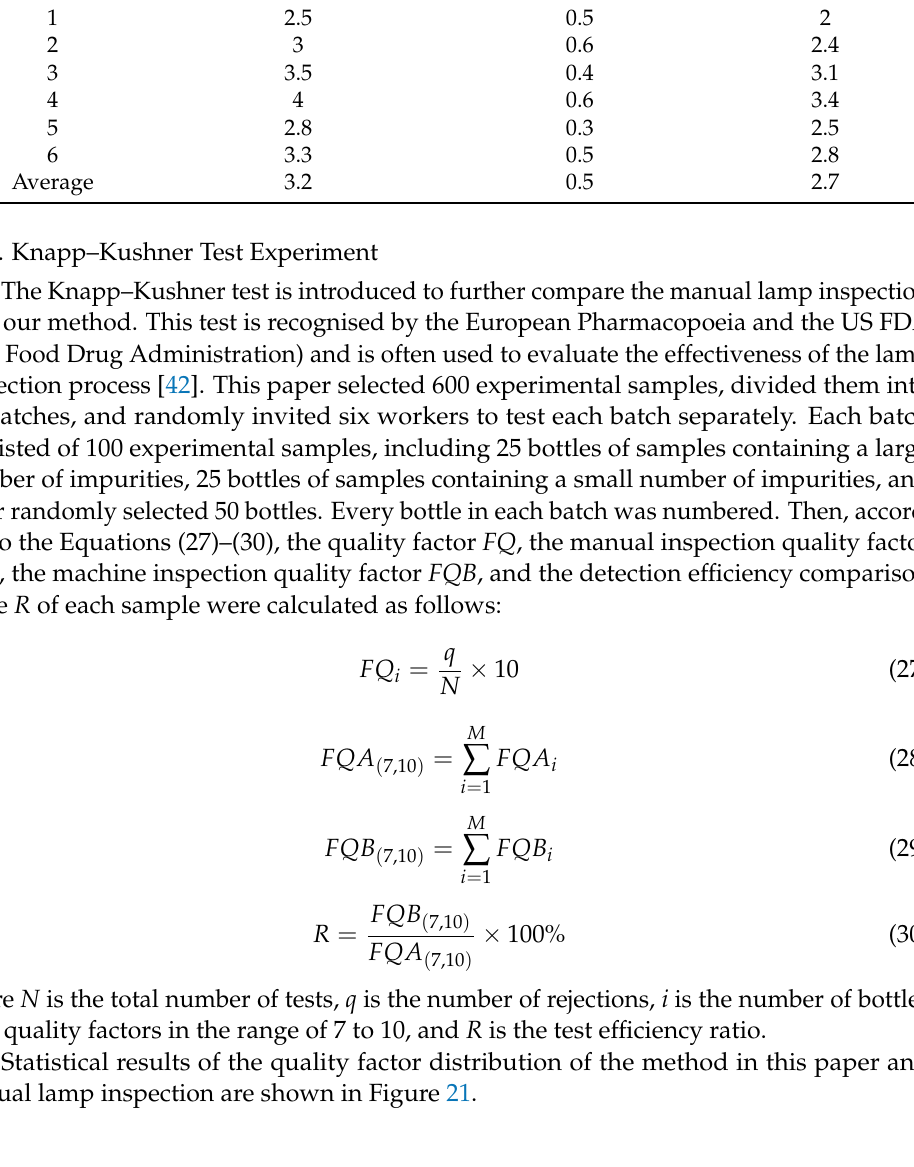
Table 6. Comparison table of the average time.